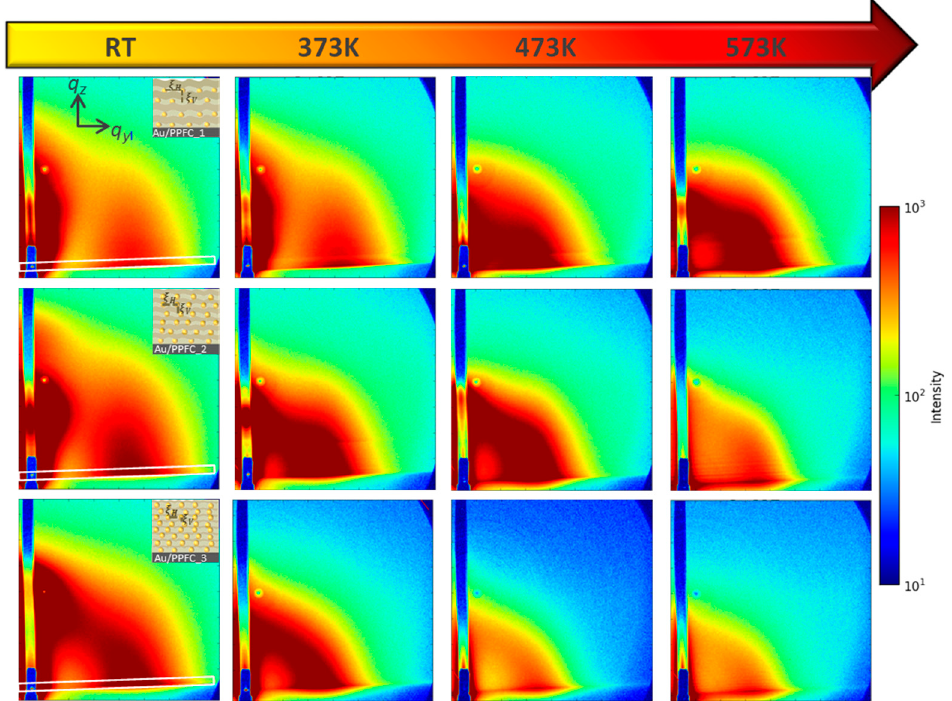
Figure 2. GISAXS pattern of MLs ( a ) Au/PPFC_1, ( b ) Au/PPFC_2, and ( c ) Au/PPFC_3 at the indicated temperatures. The white rectangle block in all three ML’s room temperature patterns shows the projected area chosen to extract structural lateral features after applying 2° tilt correction. The inset of GISAXS room temperature images of three MLs shows the schematic layer arrangement and their horizontal ( ξ H ) and vertical order ( ξ V )